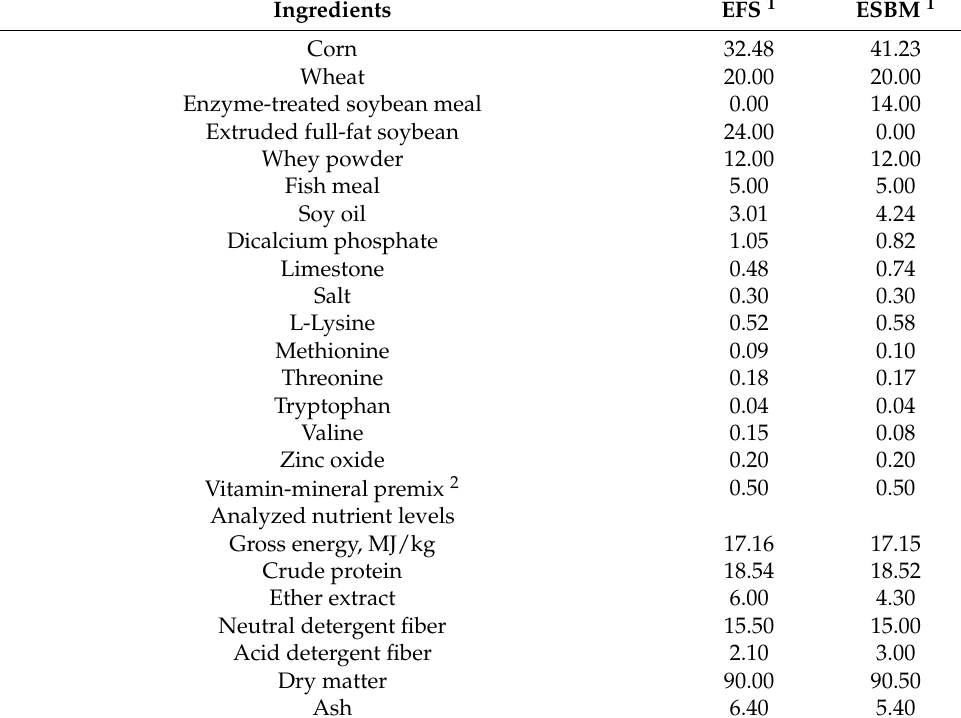
Table 1. Composition and nutrient levels of the experimental diets (%, as-fed